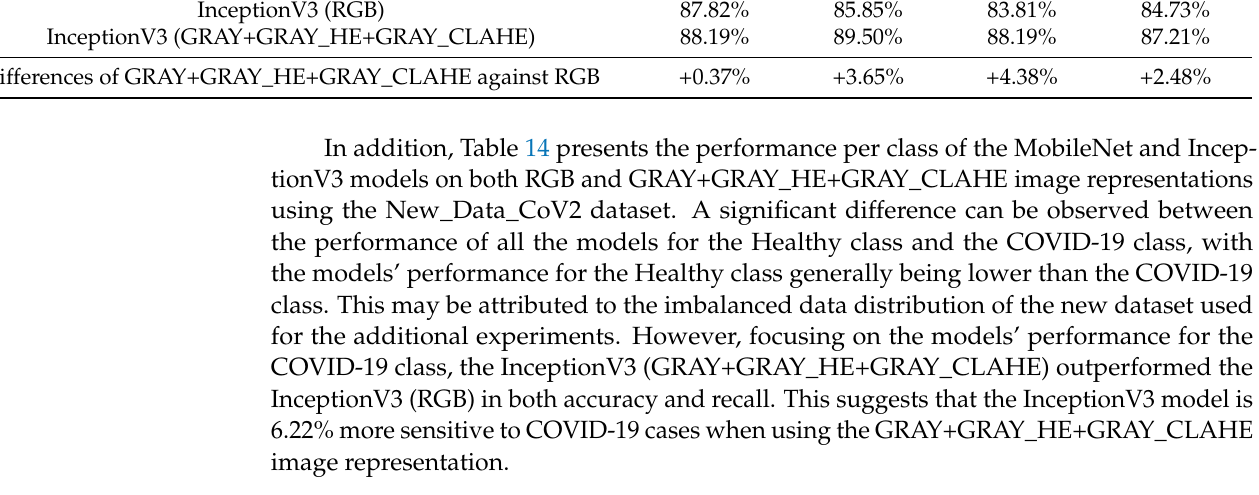
Performance per class of the MobileNet and InceptionV3 models on RGB and GRAY+GRAY_HE+GRAY_CLAHE image